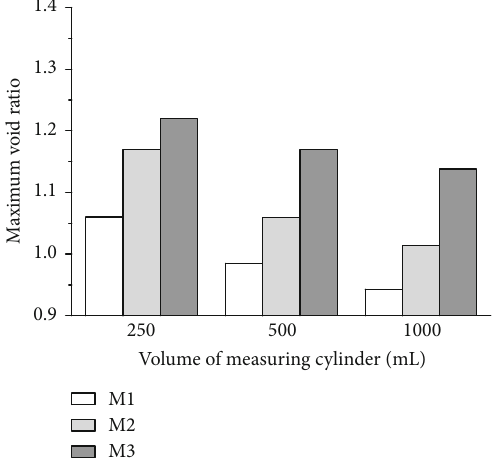
Figure 6: Maximum void ratio in di ff erent volumes of measuring